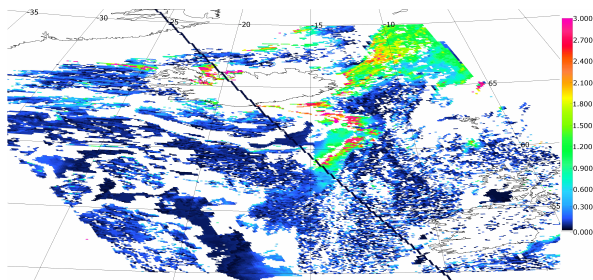
Fig. 8. RGB composites of POLDER measurements in total radi- ance. The total radiance values are relative to the PARASOL over- pass on 6 May 2010. The aerosol properties retrieved over region (3) and (4) are reported in Table 2.